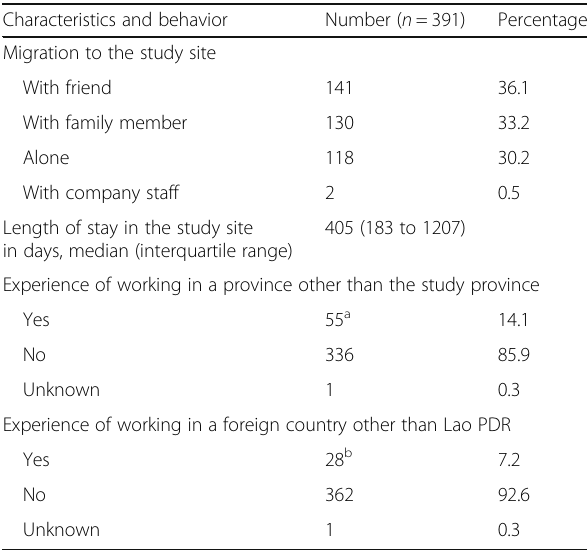
Table 2 Migration characteristics of the study